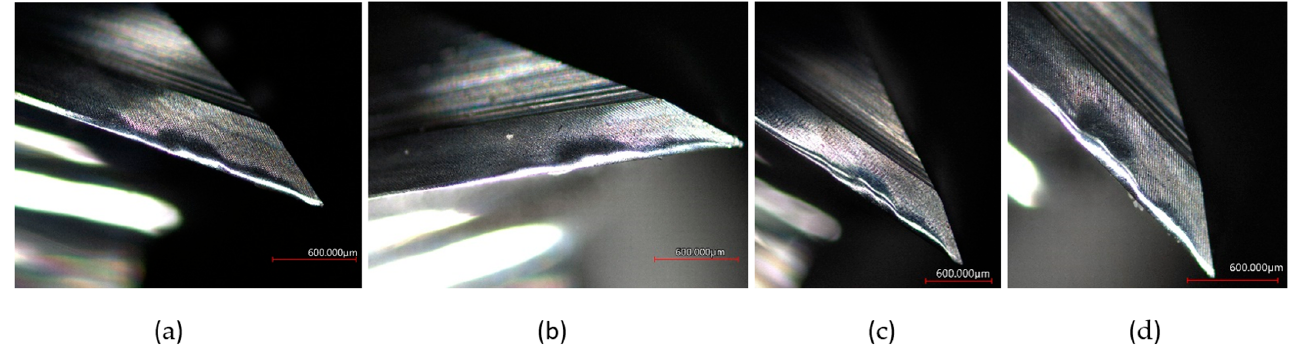
Figure 25. Tool wear of the A100 milling tool, laminate thickness 1 mm. ( a ) Tool tooth path 5 × 165 m; ( b ) tool tooth path 10 × 165 m; ( c ) tool tooth path 15 × 165 m; ( d ) tool tooth path 20 × 165